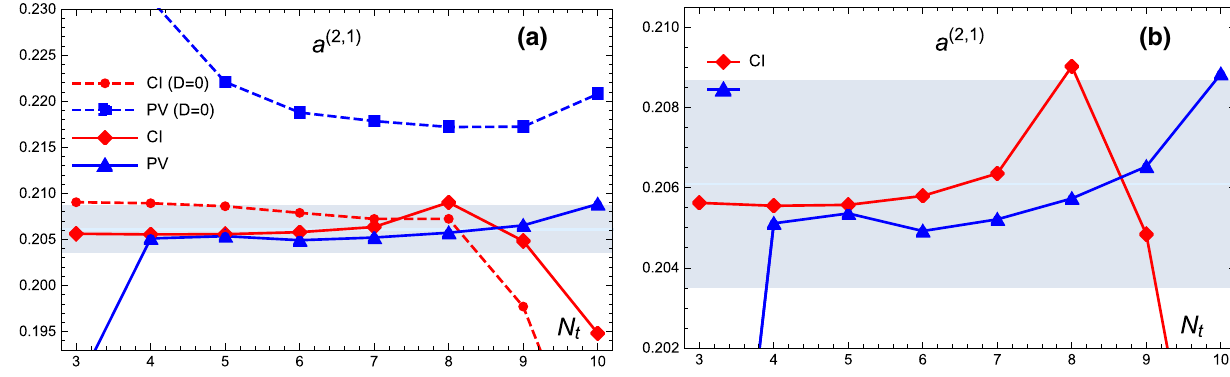
Fig. 7 The same as in Fig. 6, but for the moment a ( 2 , 1 ) (σ m ) ( = r τ (σ m ) ( D = 0 )